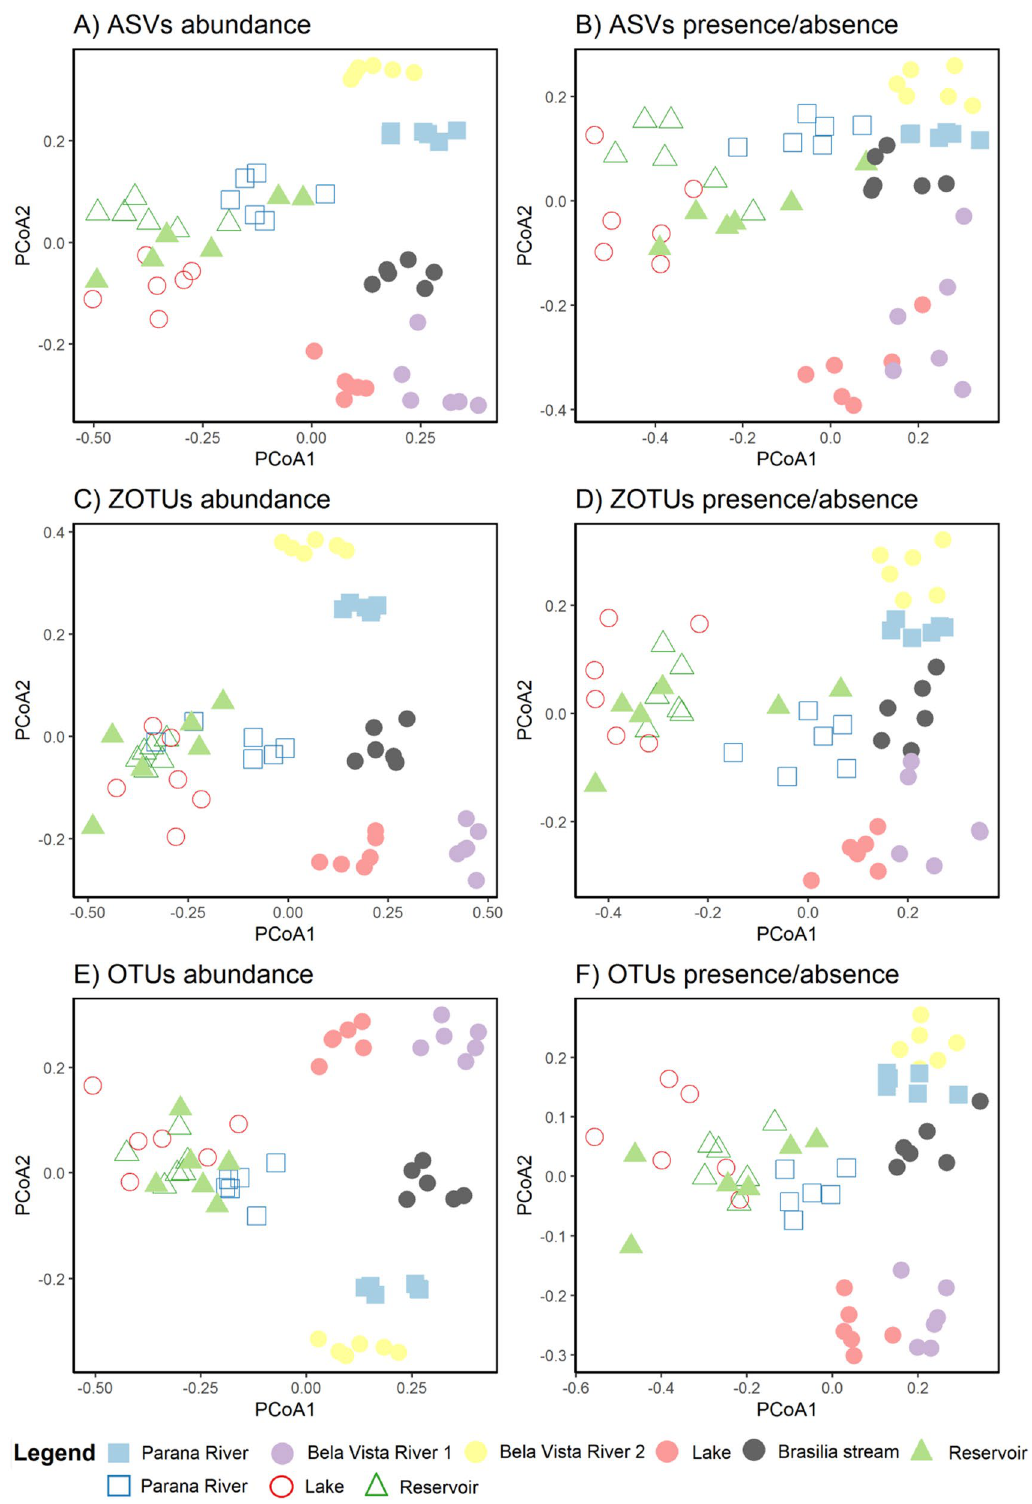
Figure 3. Principal Coordinates Analysis (PCoA) of fishes’ communities from Itaipu based in hill numbers for ( A ) ASVs abundance, ( B ) ASVs presence/absence, ( C ) ZOTUs abundance, ( D ) ZOTUs presence/absence, ( E ) OTUs abundance, and ( F ) OTUs presence/absence. The axis 1 separated mainly the samples by year, while the axis 2 separated samples mainly by locality. Each point is one of the replicates sampled. Colors and symbols represent collection points (mouth of channel at Paraná River = blue square, Itaipu’s reservoir = green triangle, and Piracema Channel = circles [Bela Vista River 1 = purple, Bela Vista 2 = yellow, Brasilia stream = gray, and lake = red]), and filled represent year of collection (fill = 2019, empty =